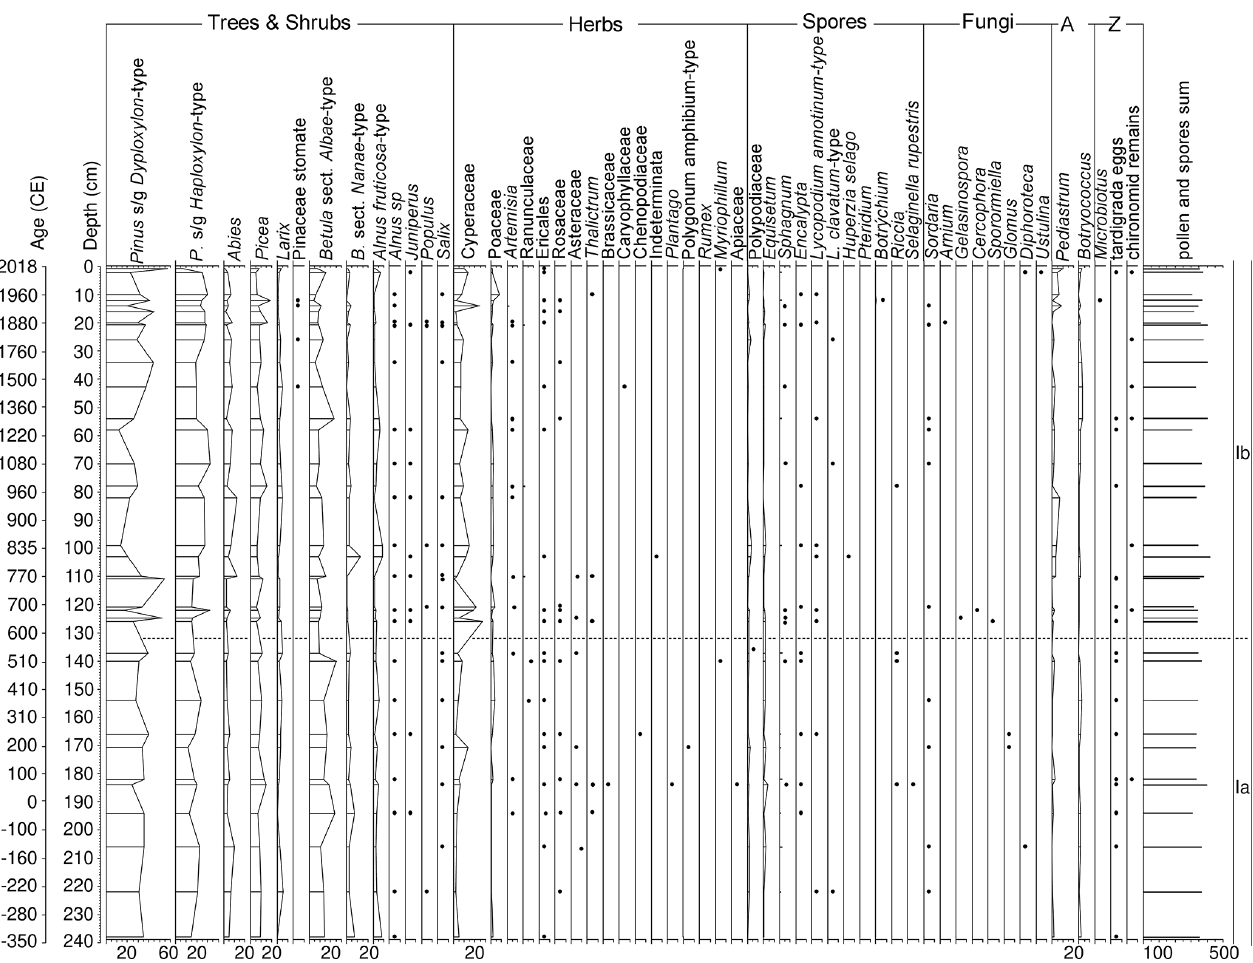
Figure 5. Pollen and non-pollen palynomorph percentage diagram from sediment core EN18232-3 at Lake Khamra (dots represent pollen taxa < 1%; A = algal remains; Z = invertebrate remains; horizontal dashed line = separation of subzones Ia and